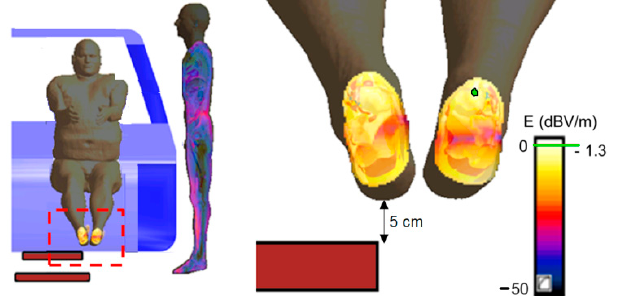
Figure 5. Induced electric field inside Duke and Fats for the aligned coil position. E-field normalized to the peak value of 13.3 V/m. BR = 11.48 V/m ≈ − 1.3 dBV/m (green area is the portion where the BR is exceeded).